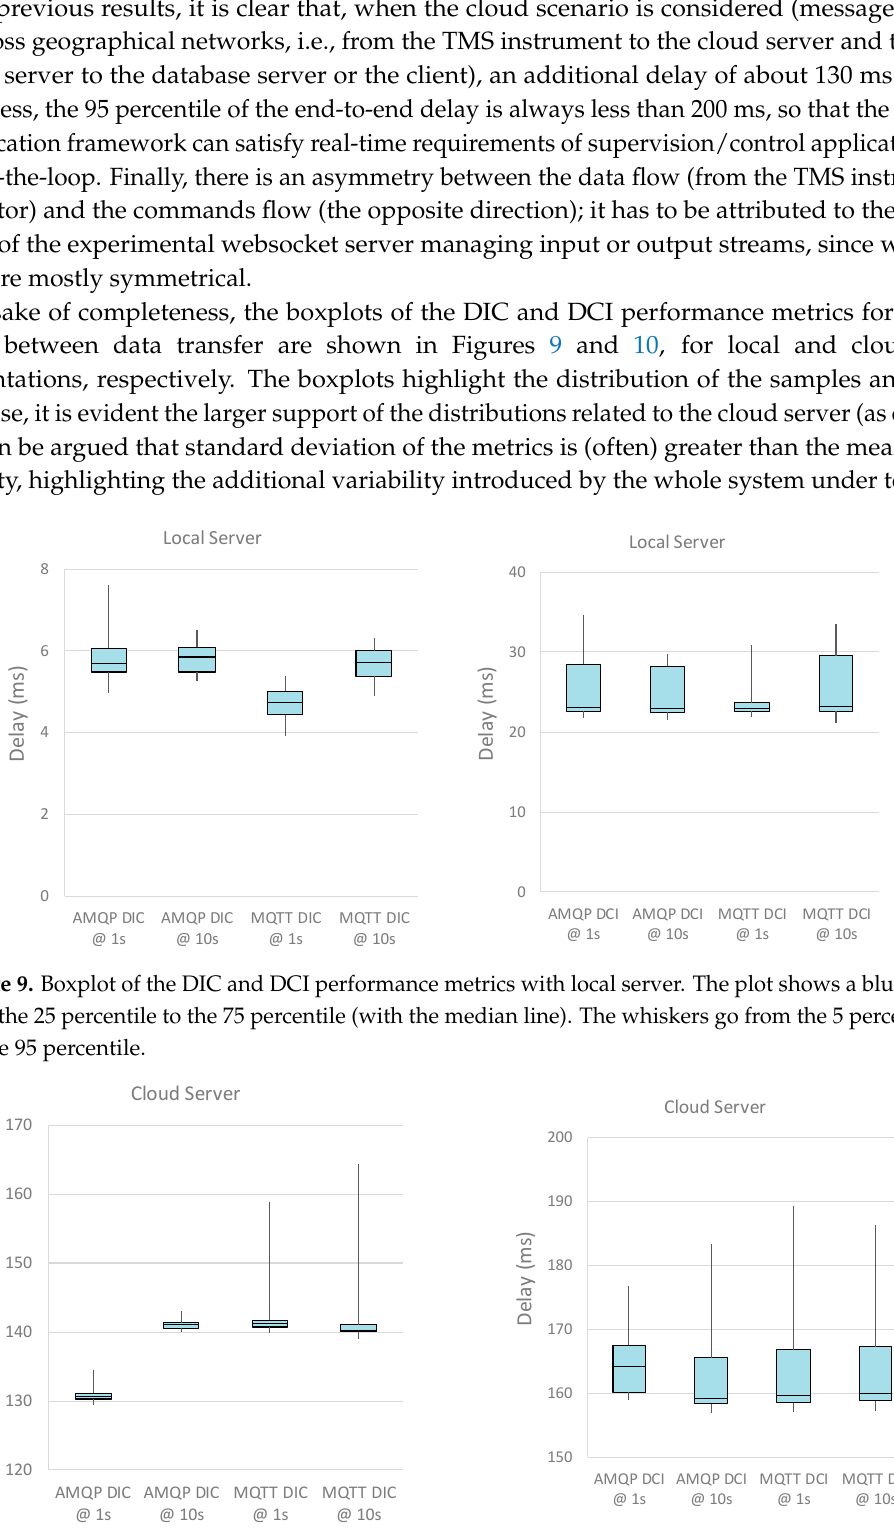
Figure 10. Boxplot of the DIC and DCI performance metrics with cloud server. The plot shows a blue box from the 25 percentile to the 75 percentile (with the median line). The whiskers go from the 5 percentile up the 95 percentile.